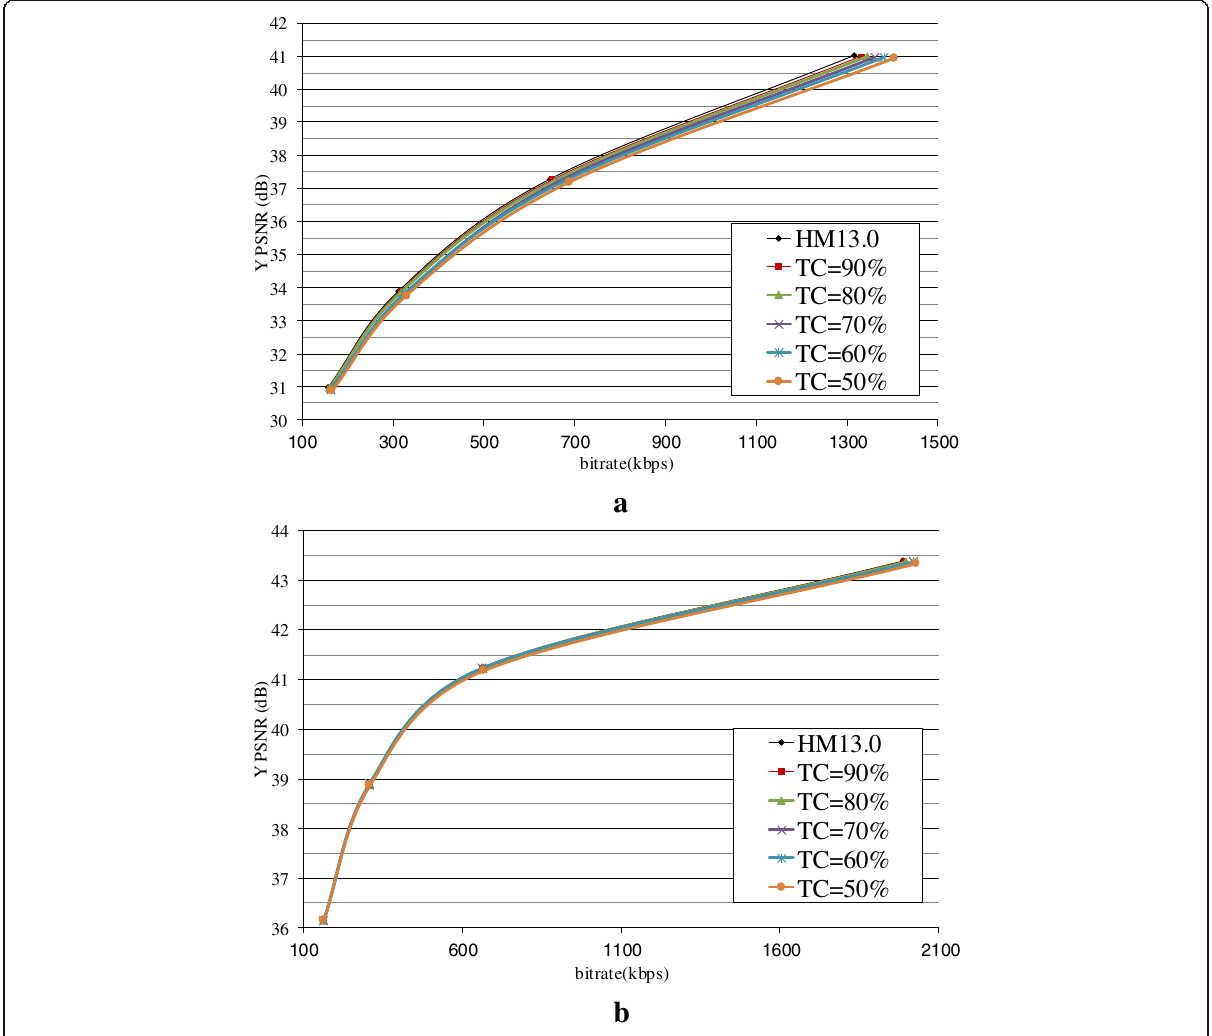
Fig. 8 Rate distortion curve comparison between HM13.0 and the five different T c . a BasketballPass. b